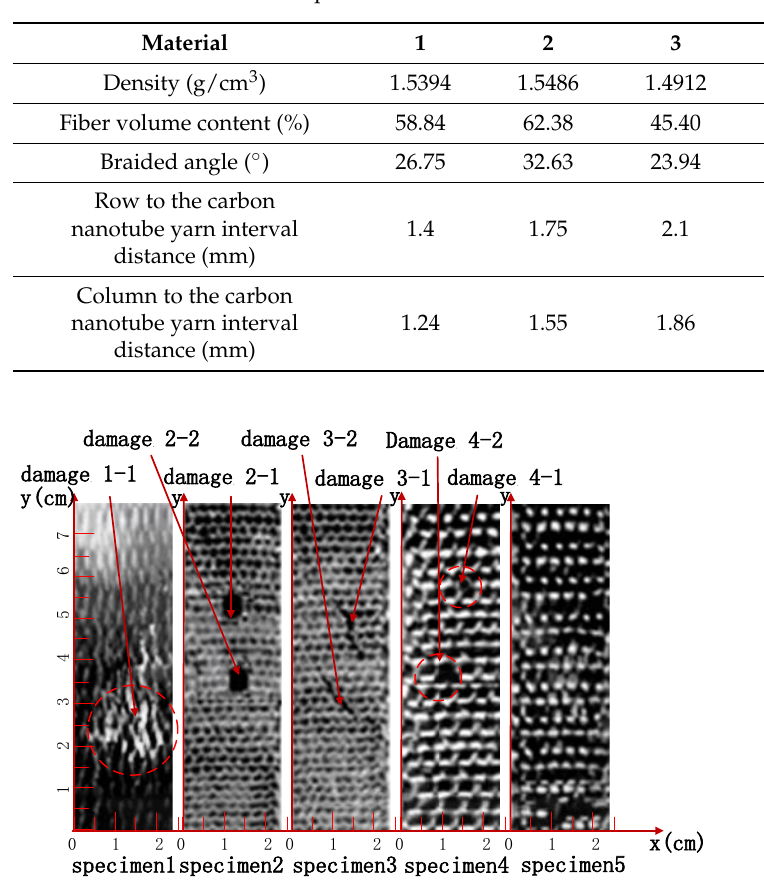
Figure 7. The 3D six-directional braided composite specimens.